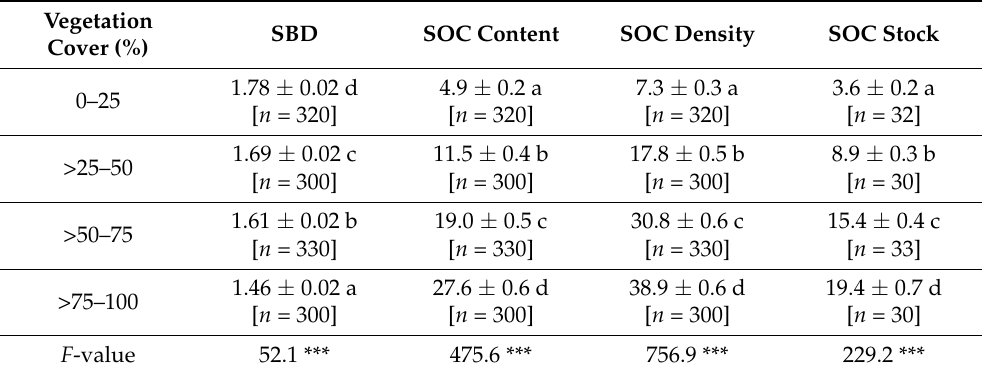
Table 1. Mean ± standard error of soil bulk density [SBD; g/cm 3 ], soil organic carbon [SOC] content sabkhas with different vegetation covers along the southern Red Sea coast of Saudi